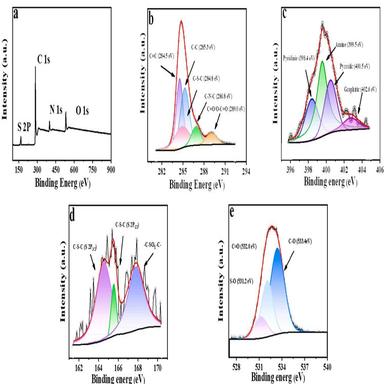
(a) XPS survey spectrum and deconvoluted core level XPS spectra of (b) C 1 s; (c) N 1 s; (d) S 2p; and (e) O 1 s for DAAQ-S/N-850 sample.